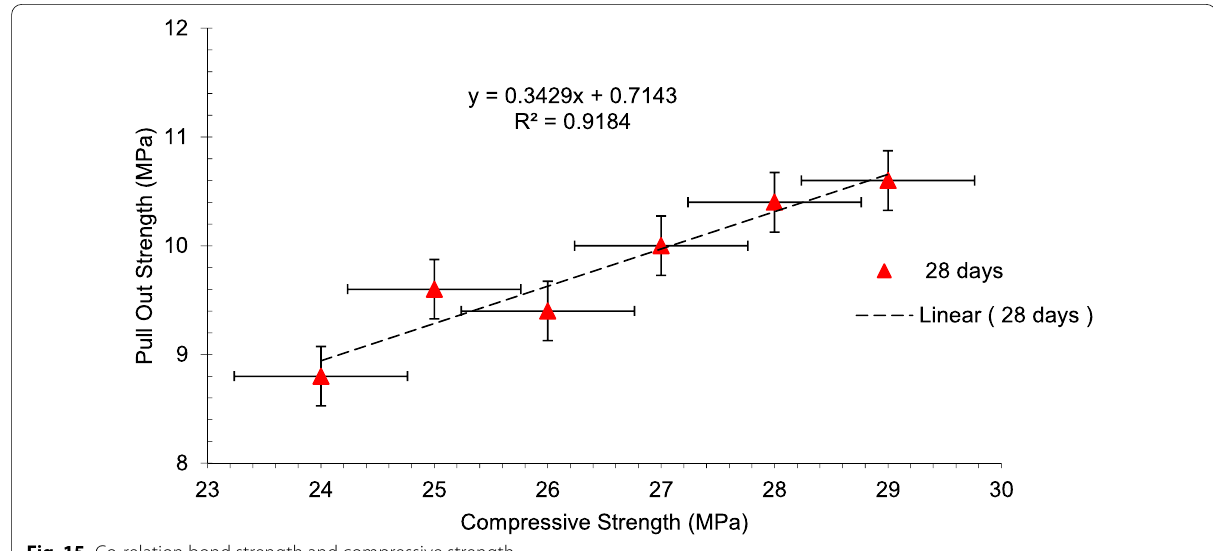
Fig. 15 Co‑relation bond strength and compressive strength.